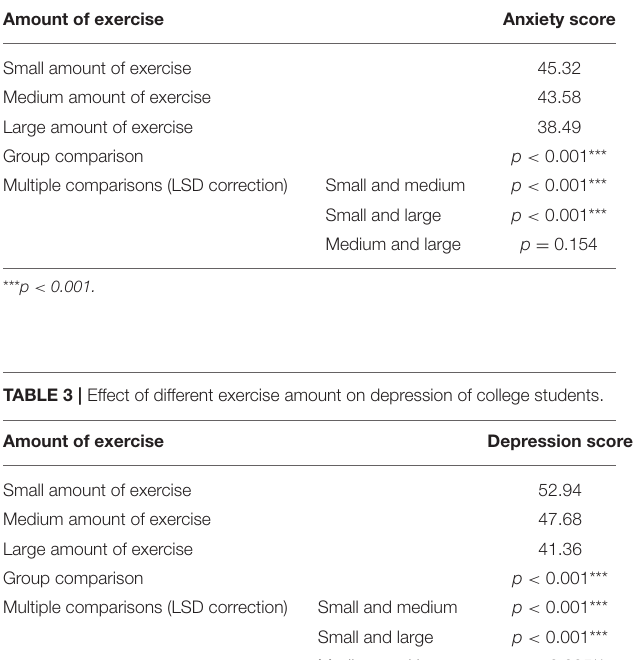
TABLE 2 | The influence of different amount of exercise on college students’ anxiety. Amount of exercise